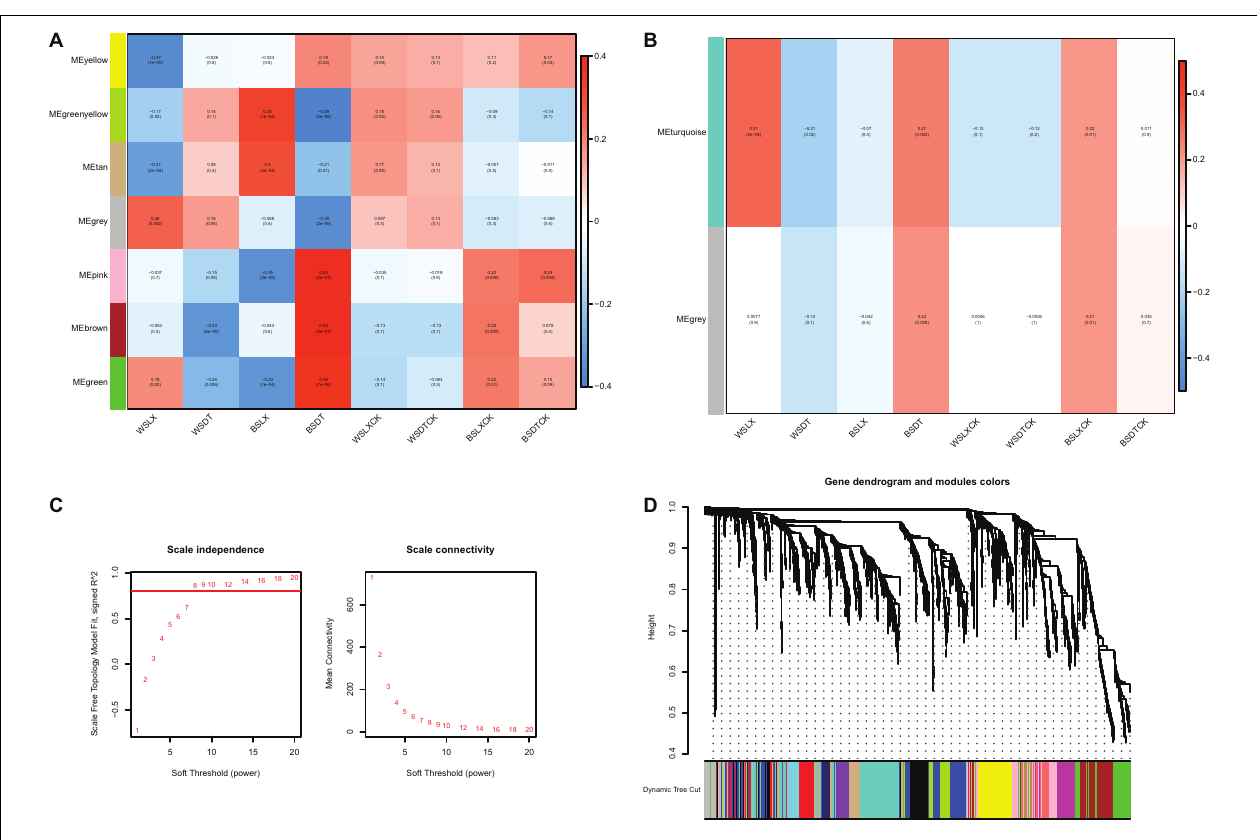
FIGURE 7 | The correlations of microbiomes. Heat map of module-trait relationship in prokaryotes (A) and fungi (B) . Each column represents the co-expression module. Red color of each box represents the positive correlation between module and trait. Blue color of each box represents the negative relationships between module and trait. The darker the module color, the more significant their relationship. (C) Estimation of soft-thresholding values in prokaryotes. Scale independence and mean connectivity of various soft-thresholding values ( β ), power of β = 11 (scale free R2 = 0.8). (D) Dendrogram of all prokaryotes enriched according to a dissimilarity measure (1-TOM) and the cluster module colors. The first set of modules was obtained with dynamic tree cut algorithm and the correlated modules were merged together. Each branch in the figure represents one genus and every color below represents one co-expression module.